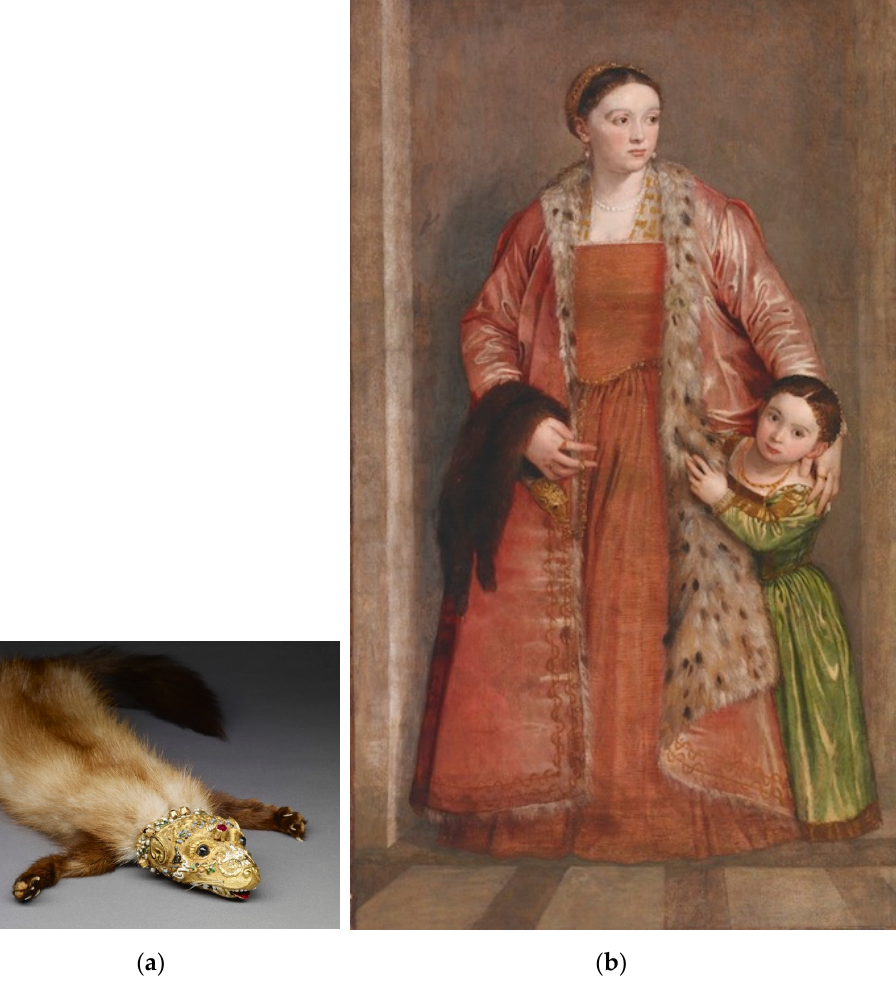
Figure 4. ( a ) Jewelled gold head of a marten. Venice, c. 1550. The Walters Art Museum, Baltimore; ( b ) A similar head set with mustelid fur is worn attached to the girdle by Countess Livia da Porto Thiene on the portrait with her daughter Deidamia, painted by Veronese in 1552 when the noble- woman was pregnant. The Walters Art Museum, Baltimore.